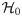
Predicted distributions of t statistics in the literature.Predicted distributions are shown under the four censoring mechanisms we consider (columns) and two possible states of nature (top row: H0 true (δ = 0); bottom row: H0 false (δ ≠ 0)).